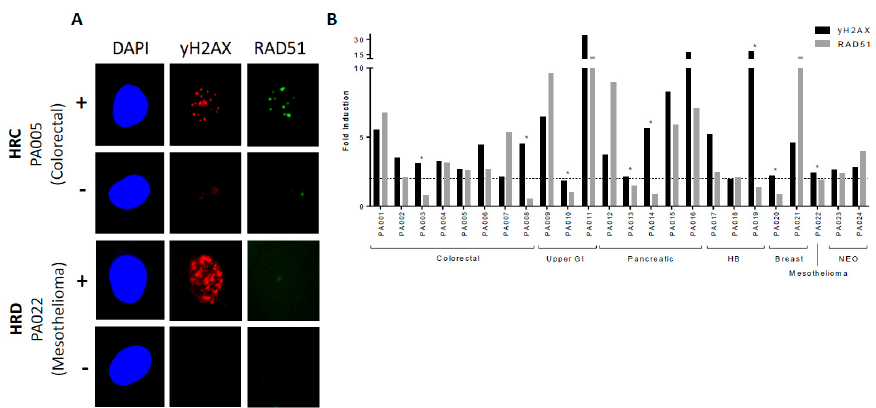
Figure 2. Determination of HRR status. ( A ) Immunofluorescence microscopy of RAD51 foci assay in in malignant cells treated with rucaparib (+) and in untreated controls (–) for PA005 and PA022 cultures. Cell nuclei were stained with DAPI (blue), before quantifying collapsed replication forks (indicated by γ H2AX foci (red) and DNA repair by HRR by RAD51 foci (green) using ImageJ software. Samples were characterised as HRR competent (HRC, PA005) if a >2-fold increase in RAD51 was observed in comparison to untreated controls following the induction collapsed replication